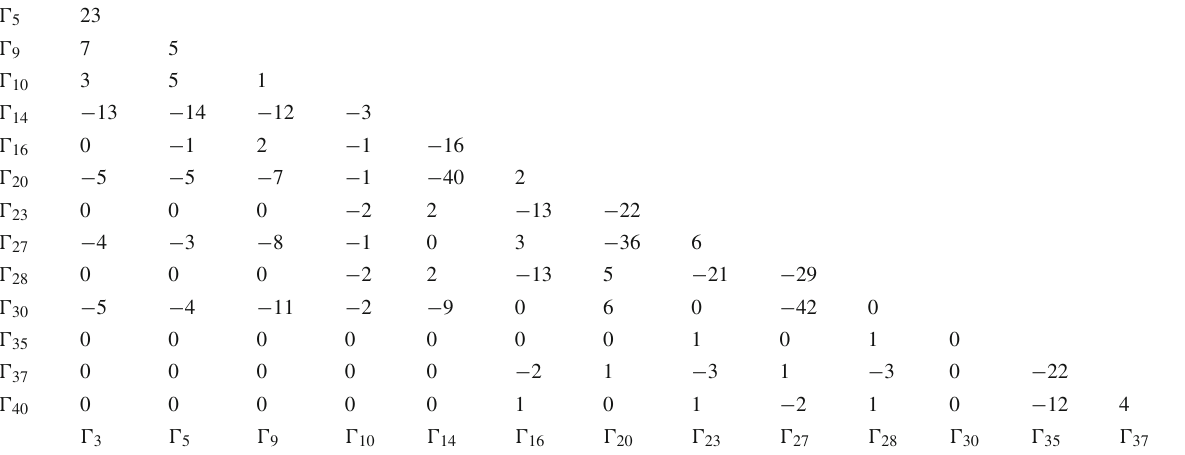
Table 305 Basis quantities correlation coefficients in percent, subtable 1